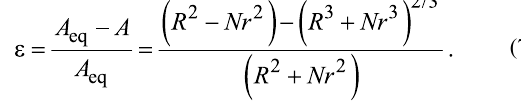
Table 1: Rates of relative area loss 1/ τ for different membrane-particle systems.